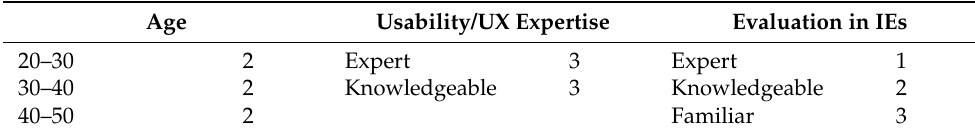
Table 2. Evaluation of participants’